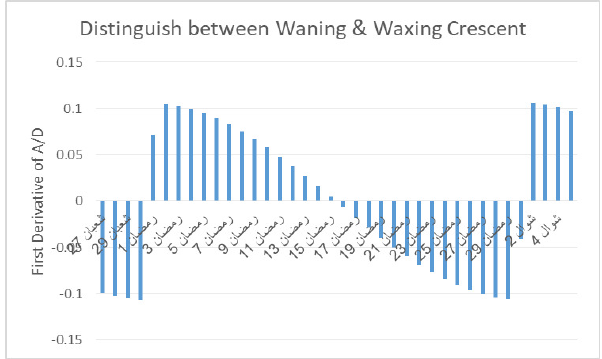
Figure 5. The rate of change of the Crescent Ratio A/D.